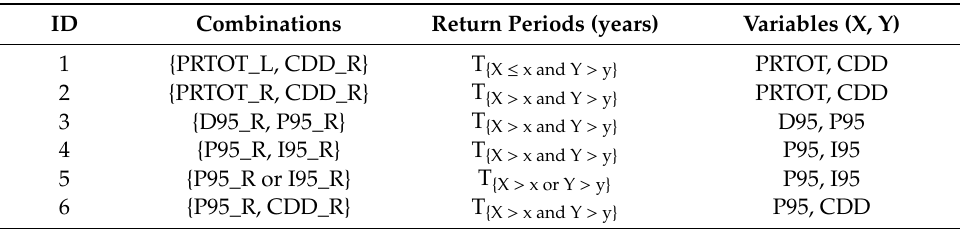
Table 3. The indicator combinations with their definitions.